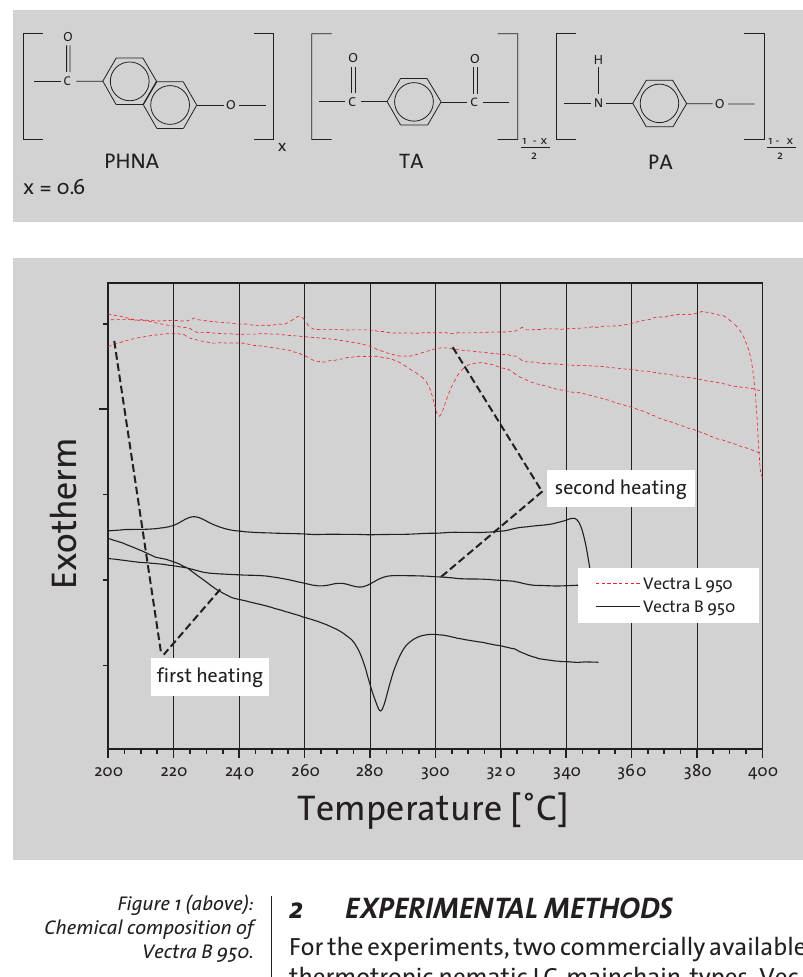
Figure 1 (above): Chemical composition of Vectra B 950. Figure 2 (middle): DSC-Analysis of Vectra B 950 and Vectra L 950.